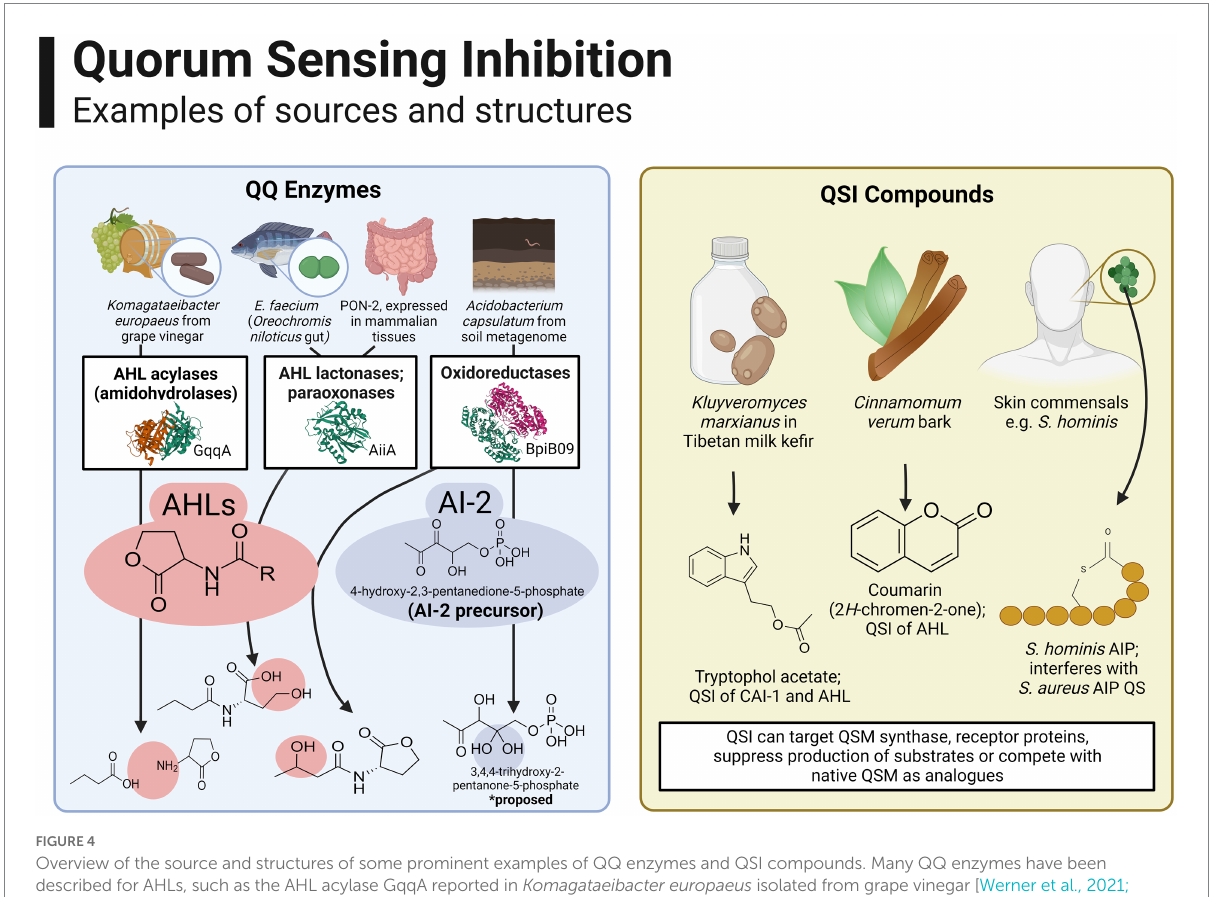
FIGURE 4 Overview of the source and structures of some prominent examples of QQ enzymes and QSI compounds. Many QQ enzymes have been described for AHLs, such as the AHL acylase GqqA reported in Komagataeibacter europaeus isolated from grape vinegar [Werner et al., 2021; Image from the RCSB PDB (rcsb.org) of PDB ID 7ALZ], AHL lactonases such as AiiA from E. faecium isolated from the gut of Oreochromis niloticus [Vadassery and Pillai, 2020; Image from the RCSB PDB (rcsb.org) of PDB ID 7L5F] and paraoxonase enzymes which are expressed widely in mammalian tissues (Peyrottes et al., 2020). Oxidoreductase enzymes have been isolated from environments such as soil and activity has been reported against AHLs (Bijtenhoorn et al., 2011; Image from the RCSB PDB (rcsb.org) of PDB ID 3RKR) as well as AI-2 (Weiland-Bräuer et al., 2016). Examples of non-enzymatic QSI include tryptophol acetate, active against CAI-1 and AHLs (Malka et al., 2021), coumarin and derivatives, which can interfere with AHL-QS (Gutiérrez-Barranquero et al., 2015) and AIP analogues produced by closely related staphylococcal species (Peng et al., 2019). Created with